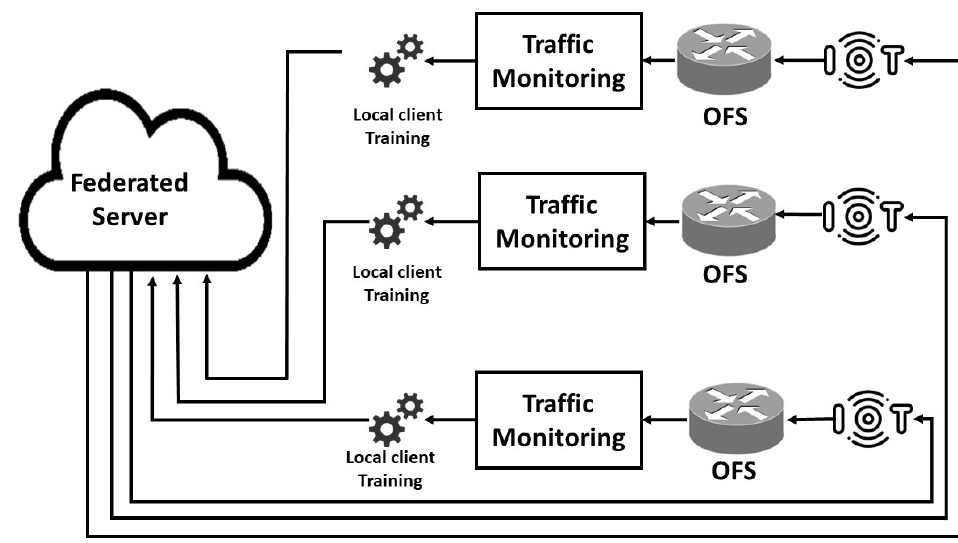
Figure 3. Federated learning based Low-Rate DDoS attack detection